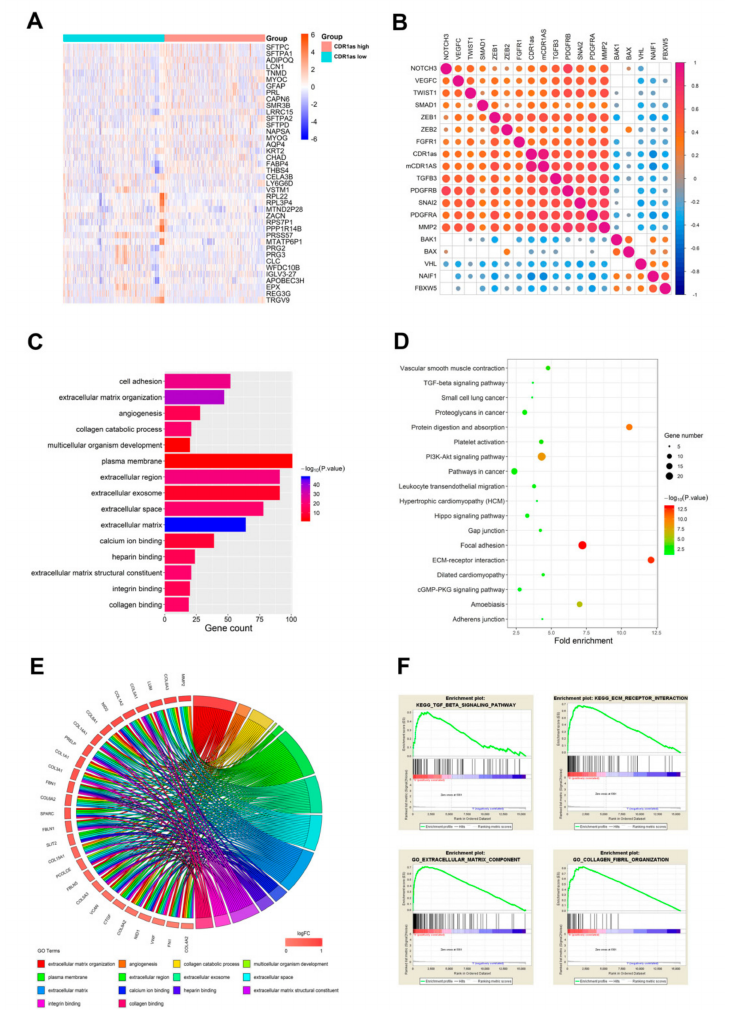
Figure 2. Comparison of gene expression profile and functional enrichment analysis of CDR1as in cancers. ( A ) Heatmap of the di ff erential expressed gene of CDR1as high expression group vs. low expression group (fold change > 2, P < 0.05). Top 20 upregulated and downregulated genes are presented. ( B ) Matrix displays some of the selected genes correlated with CDR1as expression. The color scale and the size of the dots indicate the values of pairwise Spearman rank correlation. ( C ) Top 5 gene ontology (GO) terms in cellular component, biological process and molecular function. ( D ) All enriched pathways in Kyoto Encyclopedia of Genes and Genomes (KEGG) analysis with statistical